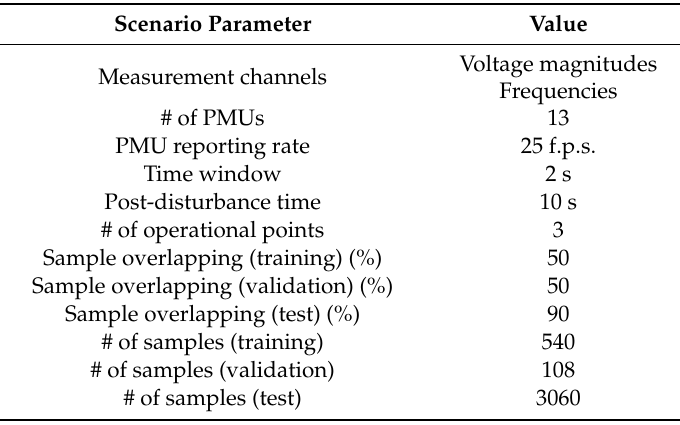
Table 11. Parameters of the base scenario.